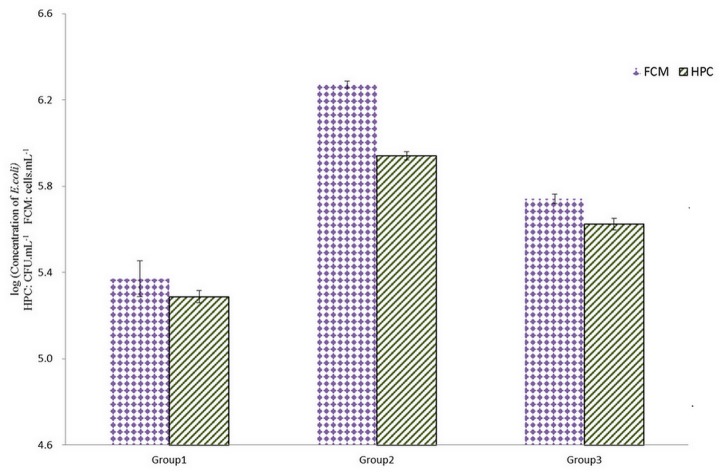
The results of two different methods to enumerate intact Escherichia coli’s concentration.SYPI stained cells were enumerated by flow cytometry for intact cell counts. The unit of FCM’s results is cells.mL-1 and the unit of HPC’s results is CFU.mL-1. All data points are average values for triplicate samples. Error bars indicate standard deviations. Group 1–3 were three groups of random Escherichia coli suspensions.